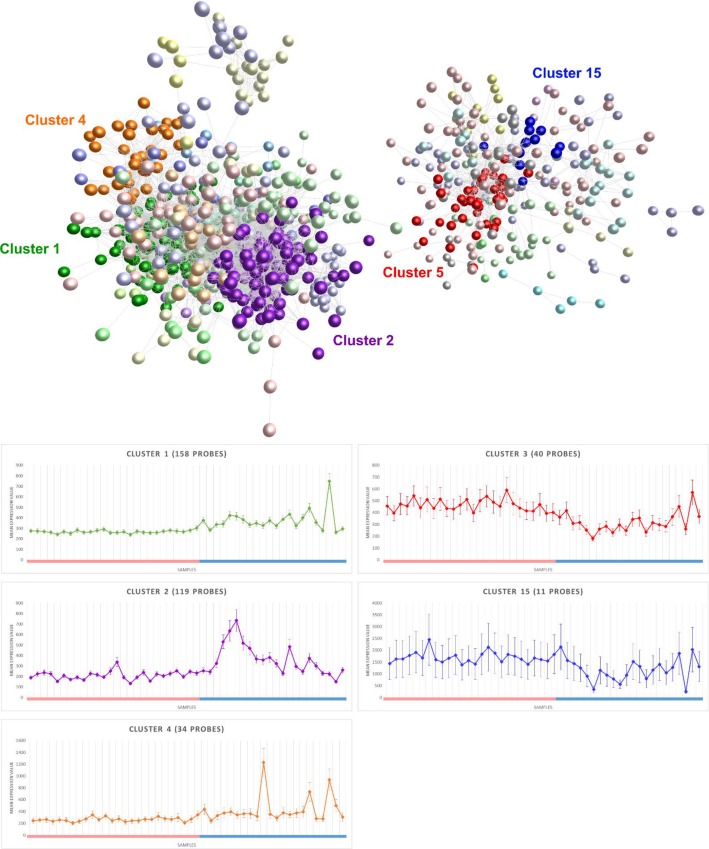
Probe-probe network graph, in which each node represents a different probe.Nodes are coloured according to membership of different MCL clusters. The graphs show the mean expression profiles of clusters 1,2,3,4 and 15. Samples are plotted on the x-axes: non-labouring samples are represented by the pink bar and labouring samples are represented by the blue bar. Error bars indicate standard errors.